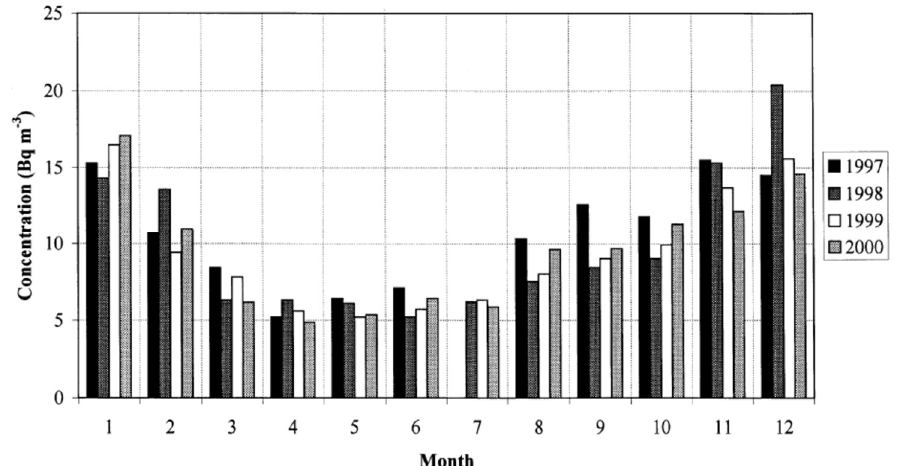
Figure 3. Monthly and year toyear variation of outdoor radon in Milan in period from 1997 to 2000. Figure is taken from Sesana et al. [66].